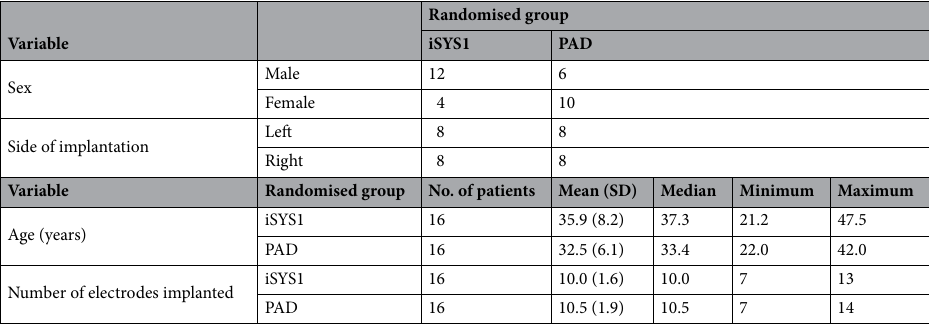
Table 2. Demographic variables, stratified by randomised group.